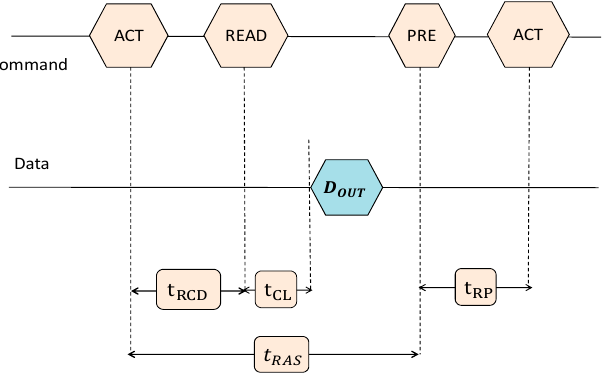
Figure 2. DRAM timing at read operation [13].